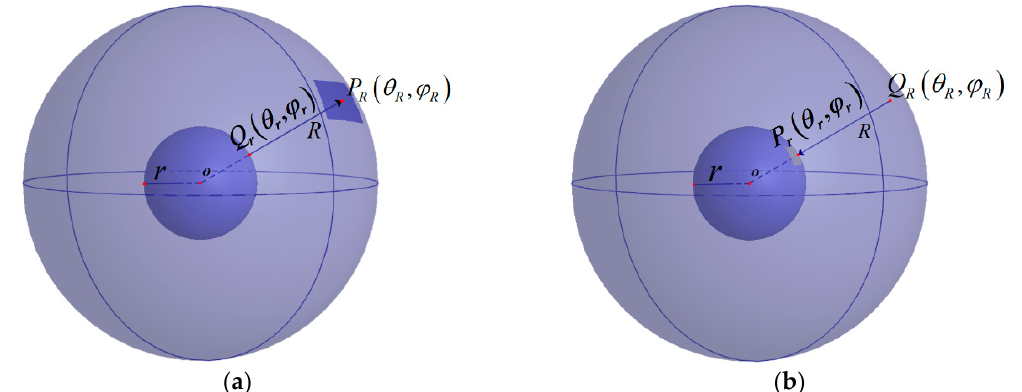
Figure 1. Spherical diffraction model: ( a ) inside-out propagation (IOP) model, ( b ) outside-in Figure1. Sphericaldi ff ractionmodel: ( a )inside-outpropagation(IOP)model, ( b )outside-inpropagation propagation (OIP) model. (OIP)